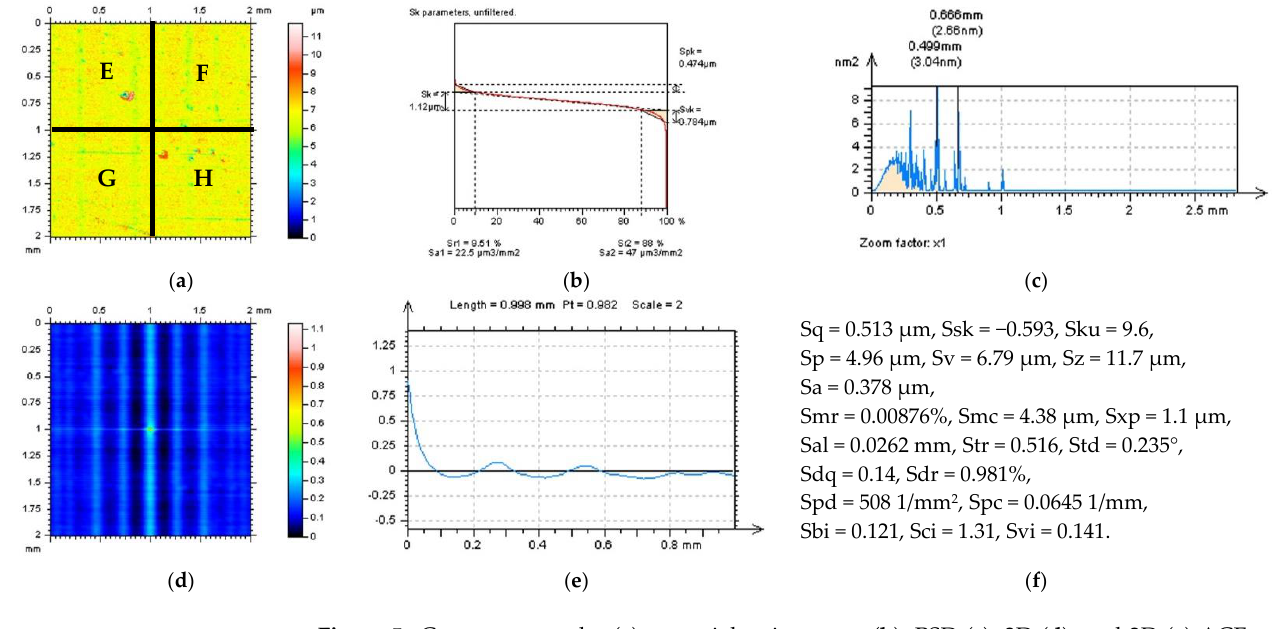
Figure 5. Contour map plot ( a ), material ratio curves ( b ), PSD ( c ), 3D ( d ), and 2D ( e ) ACF with ISO 25178 topography parameters ( f ) received from the turned surface containing several features.